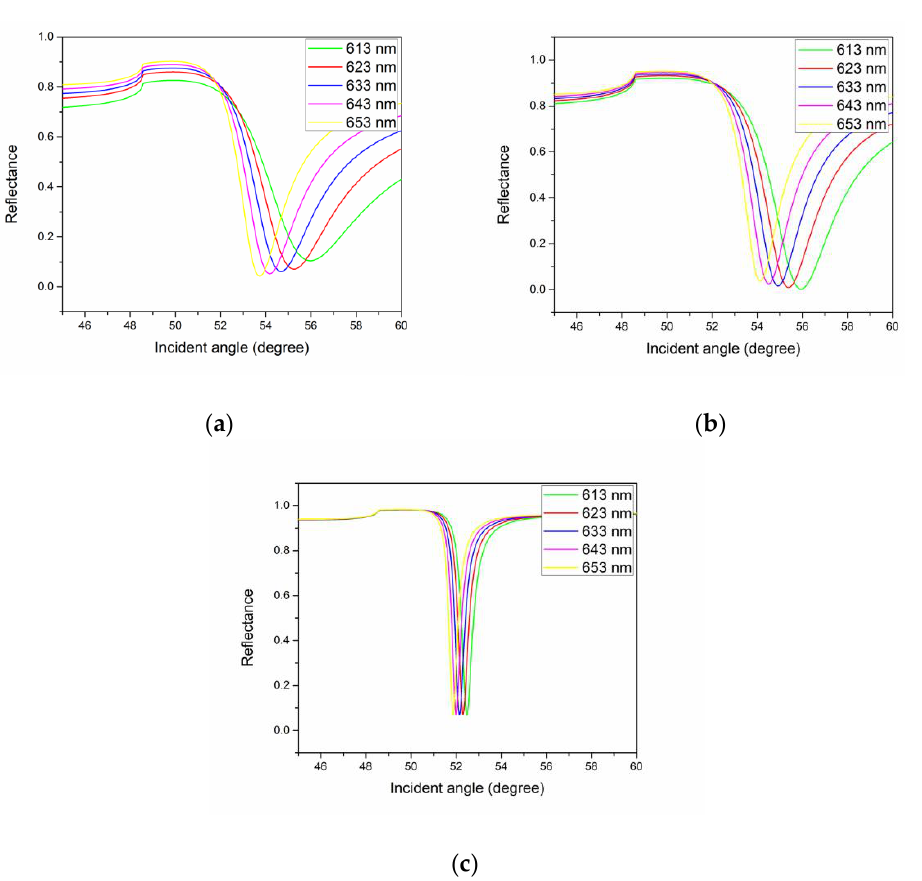
Figure 7. Optimization of the SPR signal based on different wavelengths of light sources for ( a ) copper, ( b ) gold, and ( c ) silver.